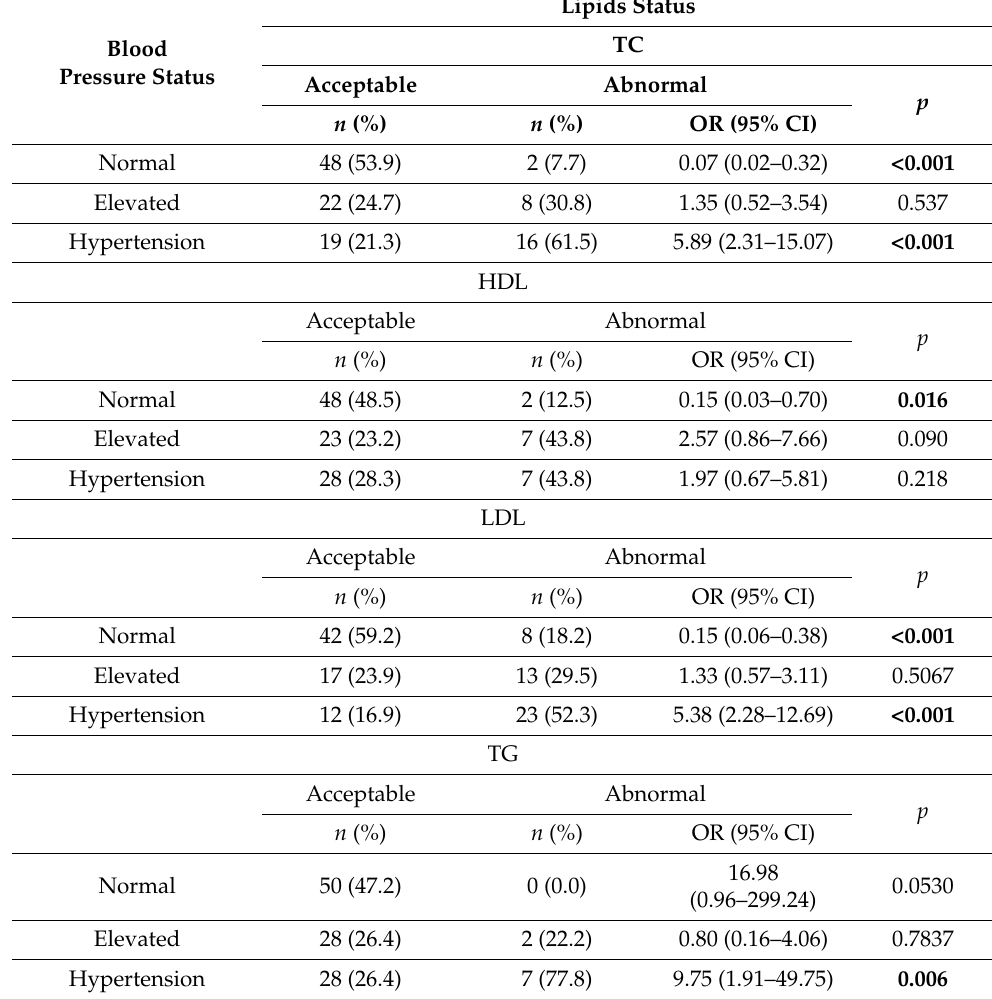
Table 8. Odds ratios for the prevalence of hypertension depending on the state of blood